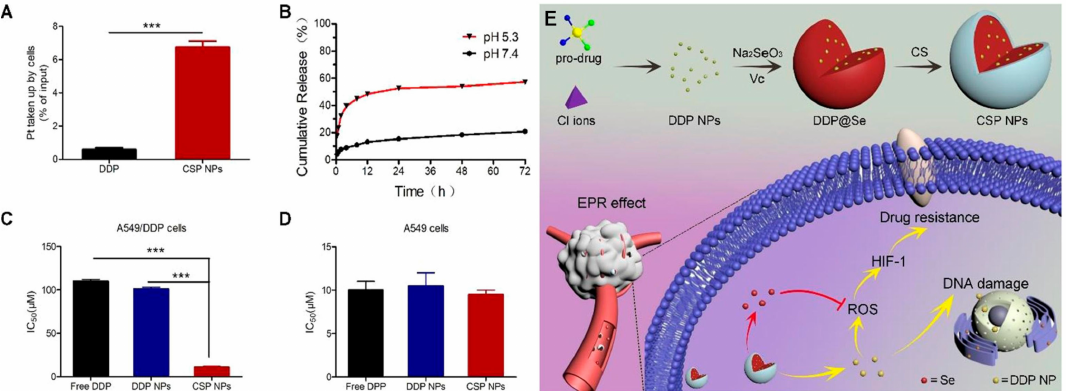
Figure 8. The quantitative intracellular uptake of free DDP and the CS-coated Se/DDP nanoparticles (CSP NPs) ( A ). pH-responsive release of CSP NPs. ( B ). The IC 50 values of free DDP, DDP NPs, and CSP NPs against A549/DDP and A549 cells ( C , D ). The design and function of CSP NPs ( E ). *** p < 0.001 indicated statistically significant